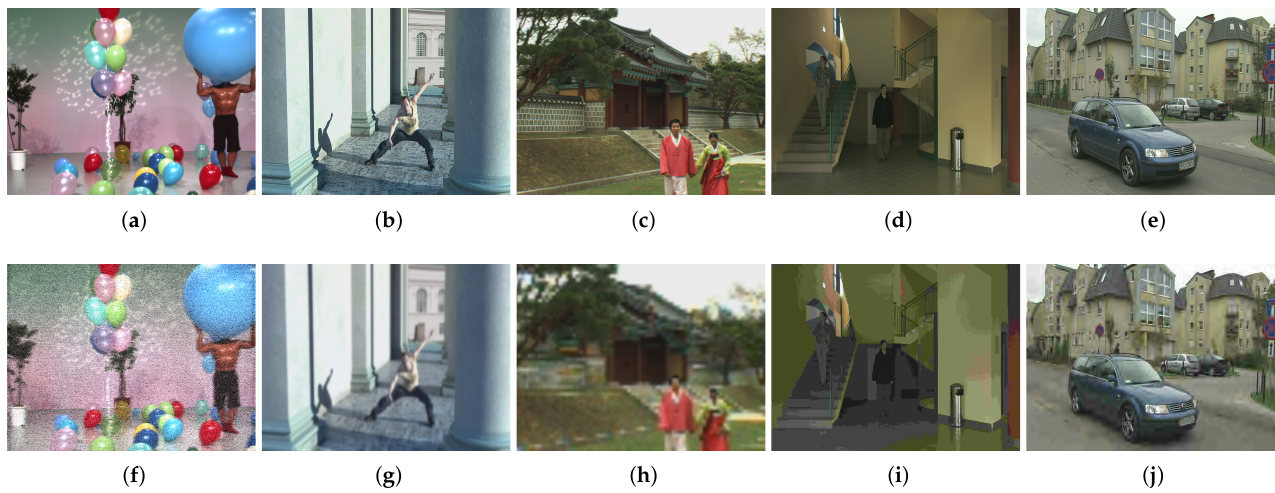
Figure 3. Top row: sample reference images from Balloon ( a ), Dancer ( b ), Love_bird1 ( c ), Poznan_Hall2 ( d ), and Poznan Street ( e ) 3D sequences, from the MCL-3D dataset. Bottom row: top image with AWN ( f ), Gauss ( g ), Sample ( h ), JPEG ( i ), and JP2K ( j ) distortions,